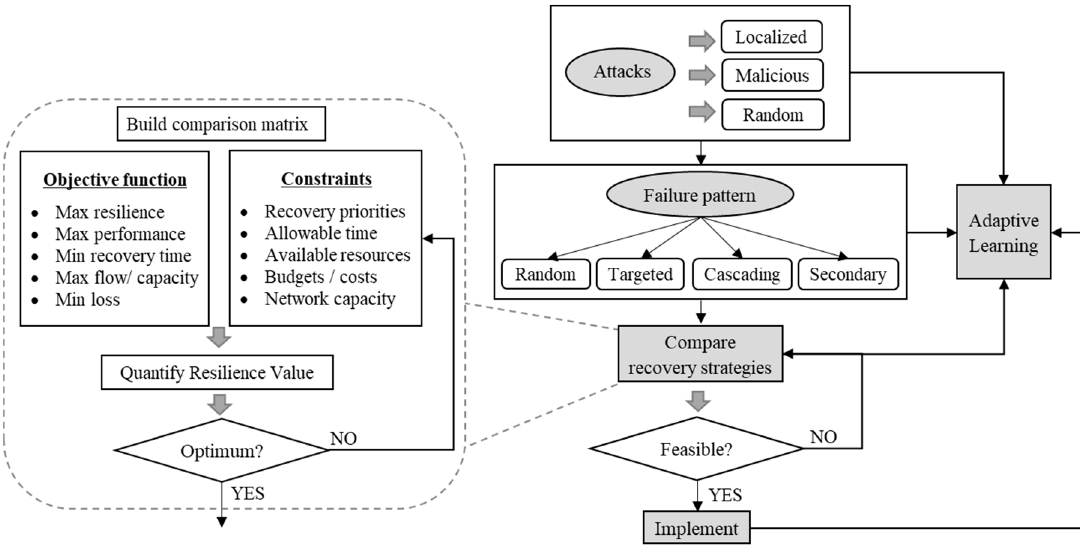
Figure 3. General resilience-based recovery assessment framework.